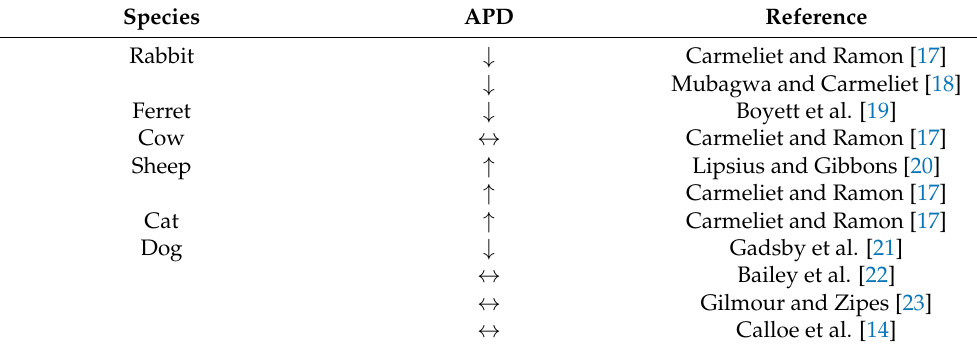
Table 1. Effects of acetylcholine on action potential duration of Purkinje fibers in animal studies.